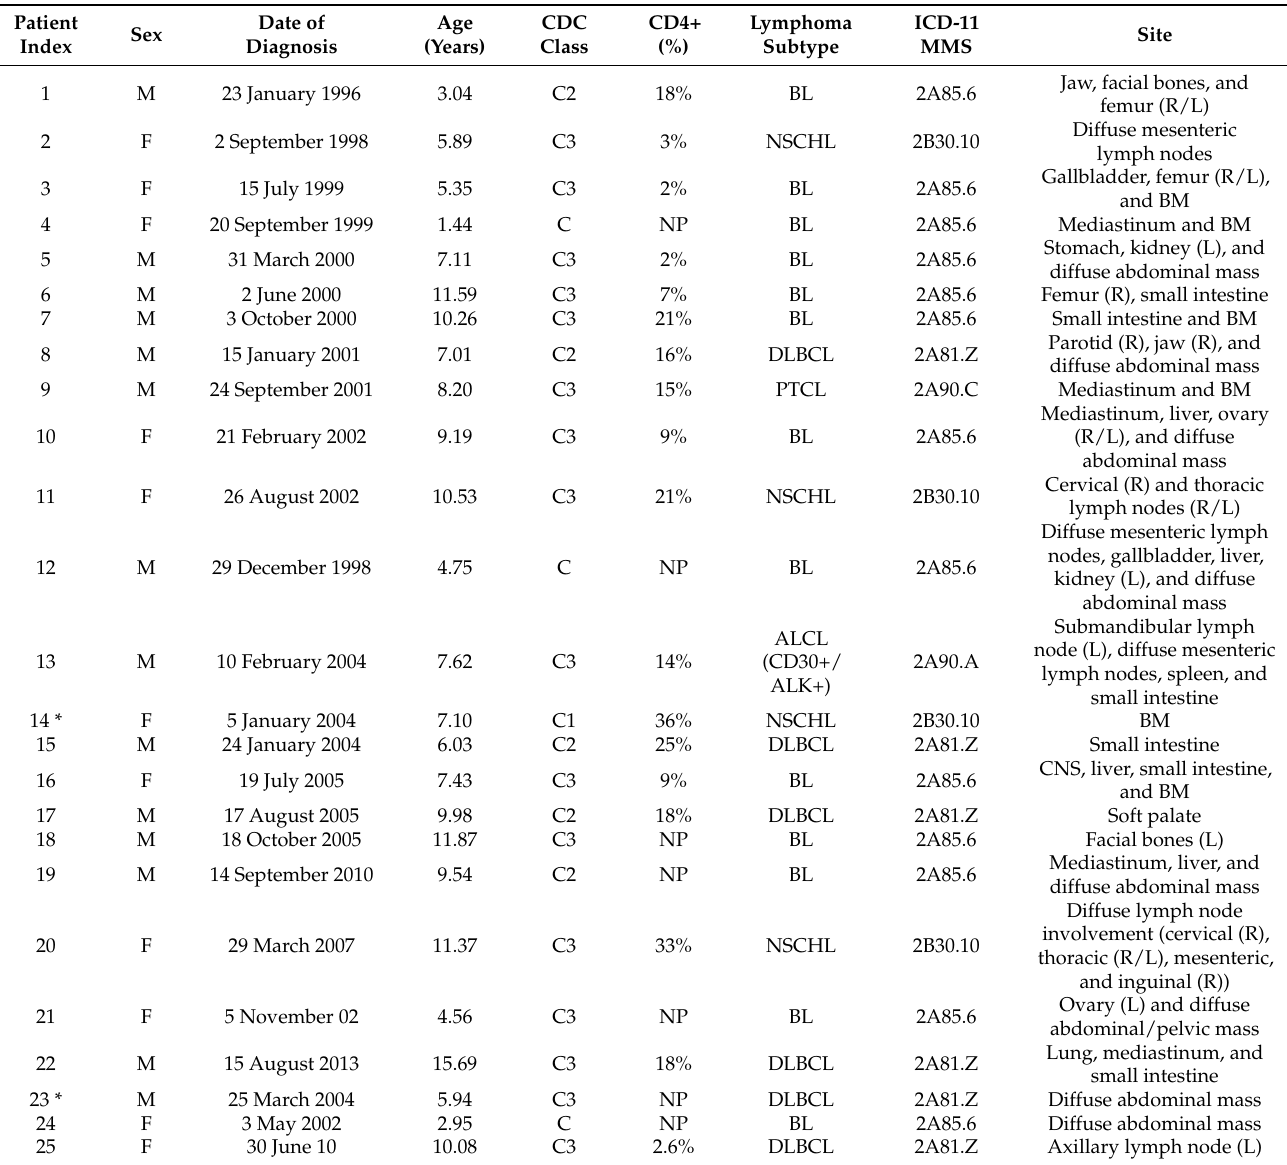
Table 1. Presenting features of 25 HIV-Vertically Infected Children and Adolescents who developed